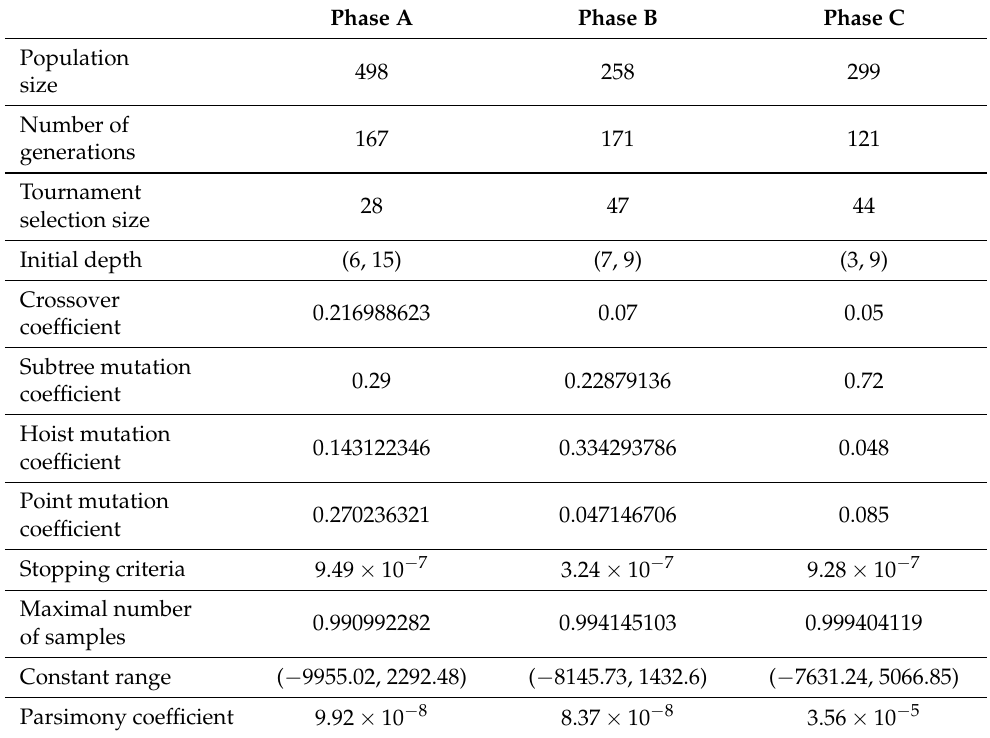
Table 5. The genetic programming parameters used for the definition of the symbolic expressions for duty cycles